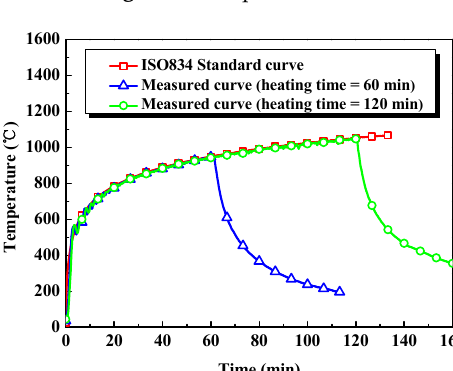
Figure 4. Setup of fire test.